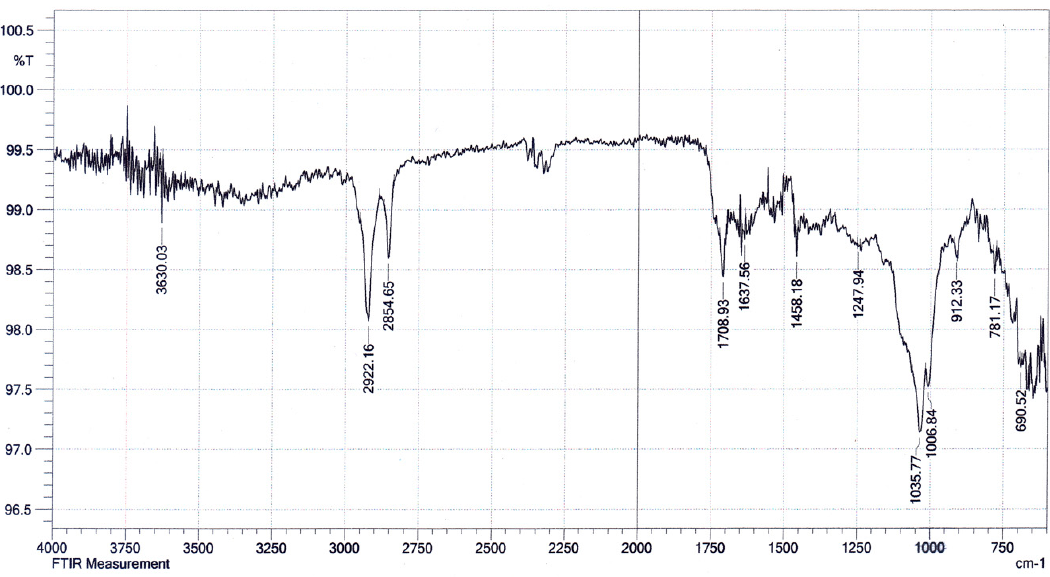
Figure 4. FTIR analysis of the olive waste.